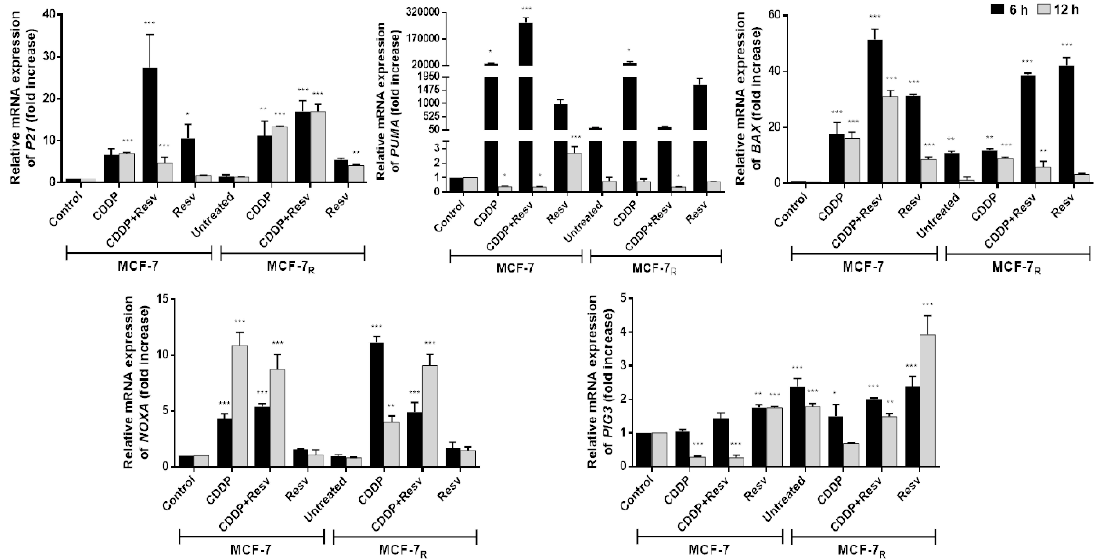
Figure 4. Early phosphorylation of p53 in S20 induced by Resv is sufficient to activate p53-dependent gene transcription in MCF-7 R cells. Total RNA extracted from cells treated with DMSO-ethanol vehicle as control or CDDP (6 µ M) with or without Resv (100 µ M) for 6 and 12 h was assessed for expression levels of P21 , BAX , NOXA , PUMA and PIG3 by RT-PCR. The mRNA level of genes was normalized to the B2M housekeeping gene. One-way ANOVA followed by Dunnett’s Multiple Comparison test were used to compare untreated MCF-7 cells (used as control group) with all the other groups of data at each time point. Results are presented as mean of three independent experiments ± SD. * p < 0.05; ** p < 0.01; *** p < 0.001.